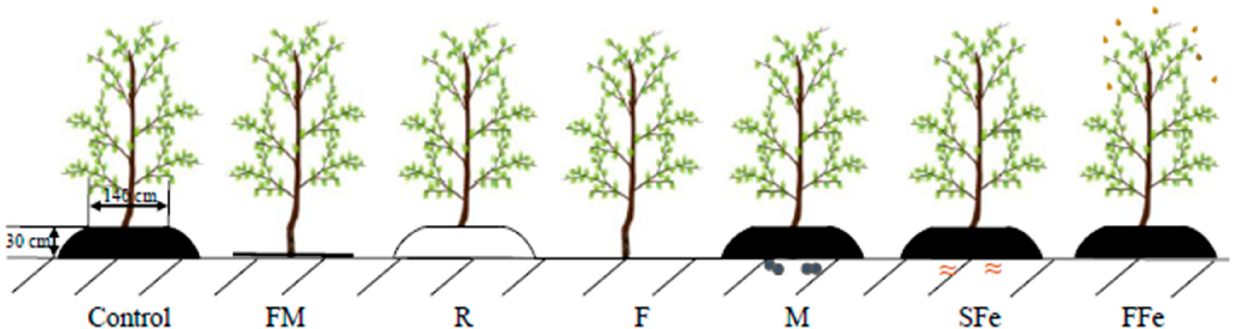
Figure 2. Schematic diagram of the practices. Control: ridging with landscape fabric mulching and without other treatments; FM: flattening with landscape fabric mulching, R: ridging without landscape fabric mulching; F: flattening without landscape fabric mulching; M: Manure application; SFe: Fe application in soil; FFe: Foliar Fe